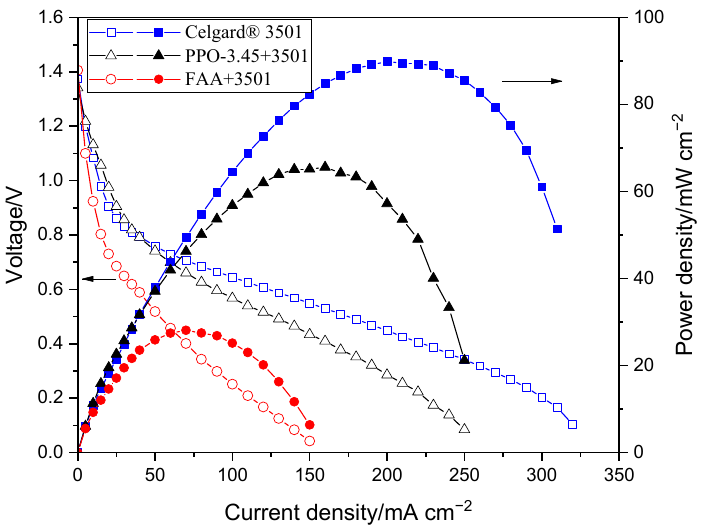
Figure 7. Polarization characteristics of the Zn slurry–air flow battery with the modified membranes.